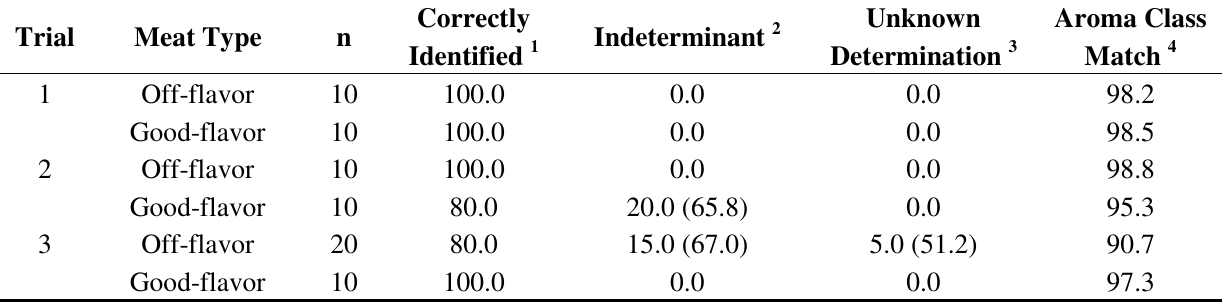
Table 2. Conducting polymer analysis tests of the capability of the AromaScan A32S e-nose to identify and discriminate between good-flavor vs. off-flavor catfish meat